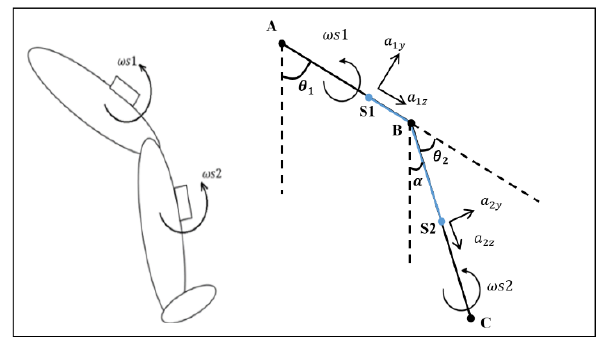
Figure 2 Schematic of the knee modeled as a hinge joint Typically, the gyroscope is left stationary for a short duration, say a 20-second period (i.e. number of samples at 20Hz sampling = 400). The measured samples are averaged to give the bias value as in equation (2) below wherein 𝜔𝑠 𝑖 is the i th sample of angular rate measured by the